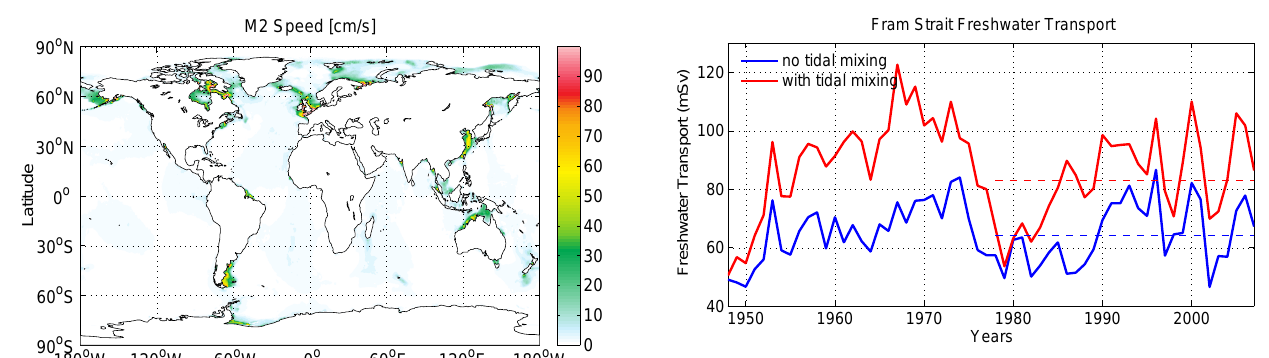
Fig. 9. Time series of Fram Strait freshwater transport (mSv − 1 Fig. 19. Time series of Fram Strait freshwater transport ( mSv (cid:0) 1 ). The impact of barotropic tidal mixing is illustrated.